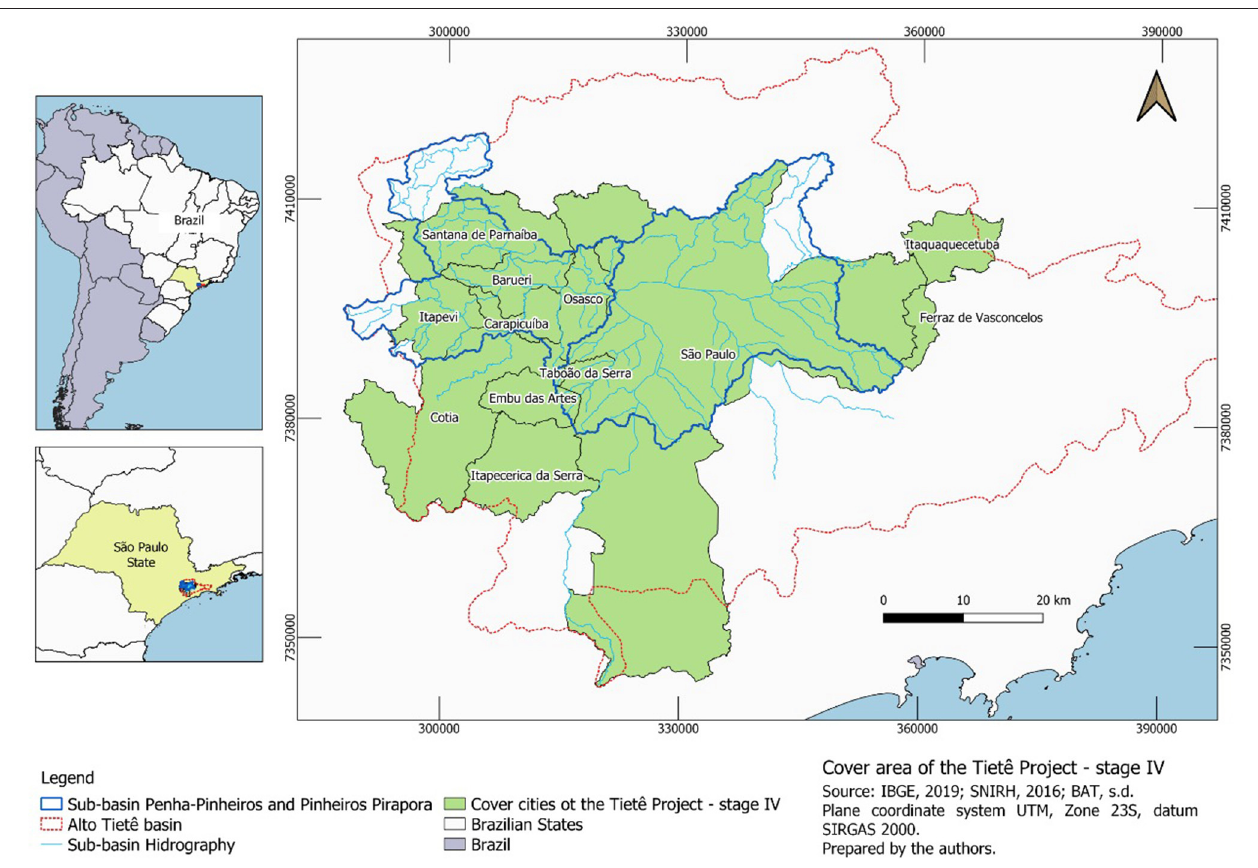
FIGURE 1 | Localization of the Pinheiros River sub-basin and municipalities covered by the 4 th phase of the Tietê River Depollution Program . Source: Designed based on SABESP, 2018; São Paulo (State), 2019a.